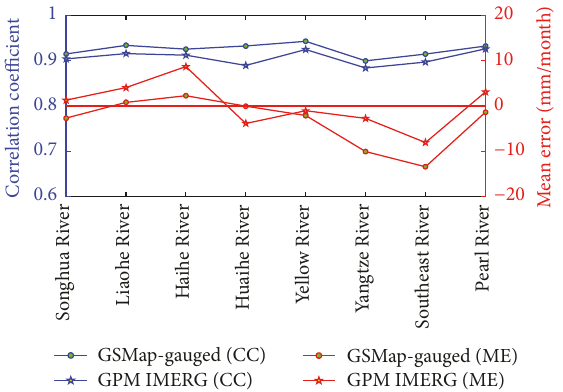
Figure 12: Spatially averaged CC and ME at the eight main basins over eastern China at the monthly scale from April 2014 to March 2016.